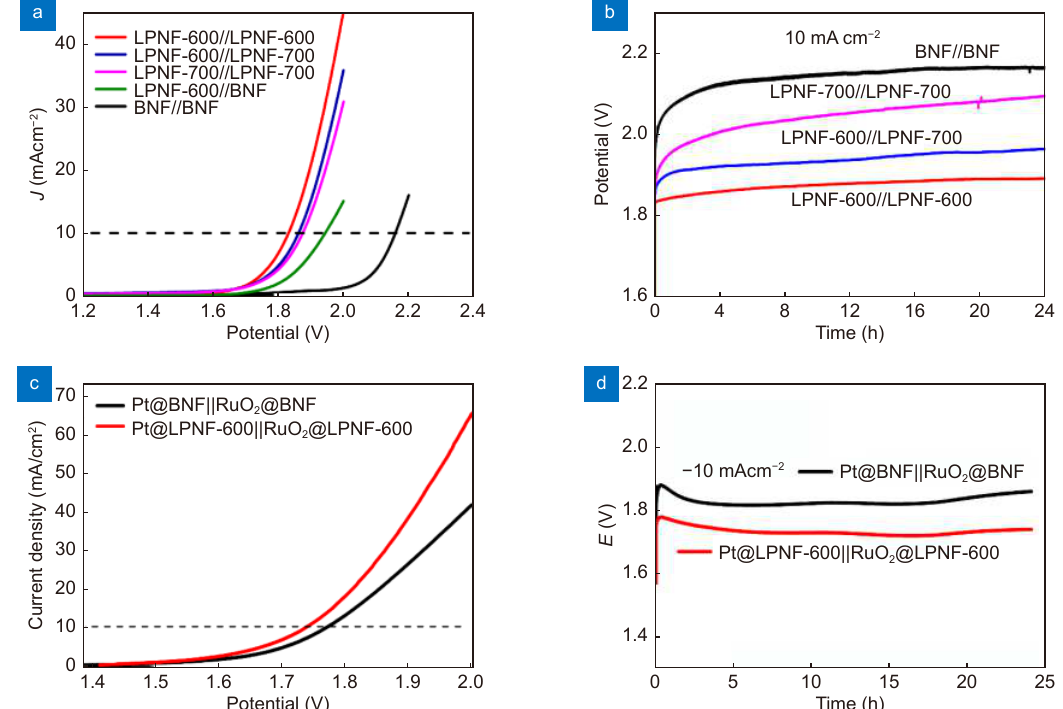
Fig. 7 | Demonstration of LEFIRC effect induced reduction in the overall water splitting potential when the LIPSS patterned electrodes are used as an anode and a cathode . ( a , b ) The LPNF surfaces are directly used as electrocatalysts for an anode and a cathode (a) the LSV curves for overall water splitting from different combinations of LPNF and BNF electrodes, and (b) corresponding chronopotentiometry Chronopo- tentiometrycurves for 24 hours. ( c , d ) A pair of LPNF-600 surfaces are used as substrates to support Pt/C and RuO 2 electrocatalysts to make cathode and anode, respectively of the cell along with a similar cell made with the BNF substrates for comparison (c) the LSV curves for overall water splitting and (d) corresponding chronopotentiometry curves for 24